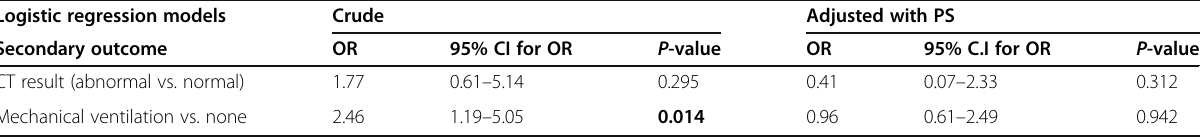
Table 4 The results of the crude and propensity score adjusted logistic regression for the secondary outcome Logistic regression models Crude Adjusted with PS Secondary outcome OR 95% CI for OR P -value OR 95% C.I for OR P -value CT result (abnormal vs. normal) Mechanical ventilation vs.